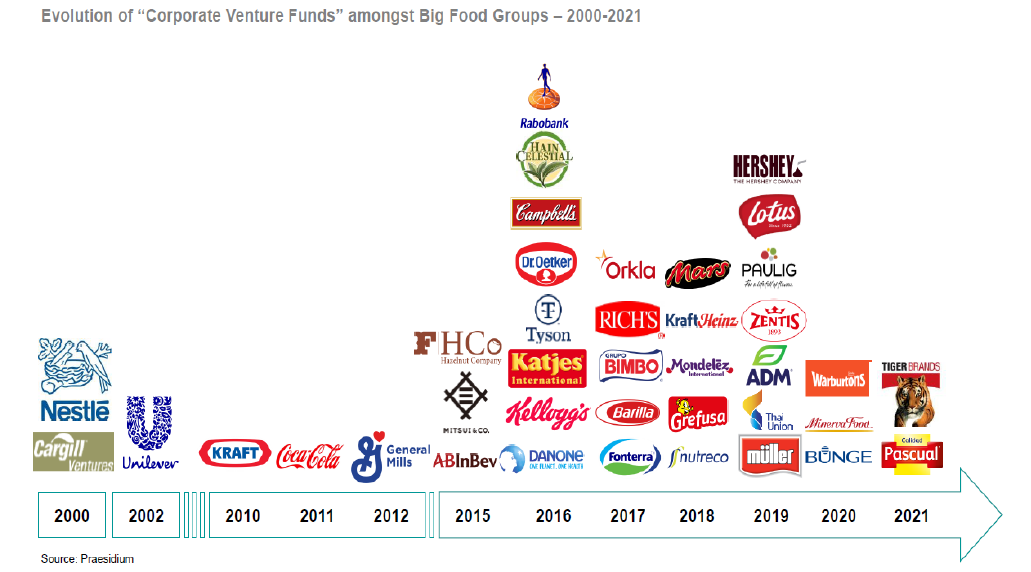
Figure 2: Corporate Ventures Agri-Foodtech